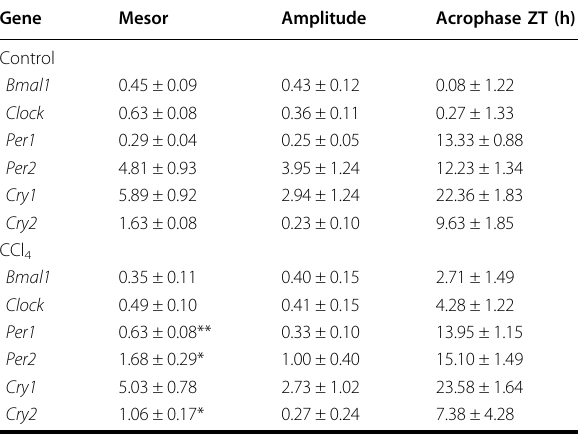
Table 1 Circadian rhythmic parameters of clock gene transcriptions in control and CCl 4 -treated